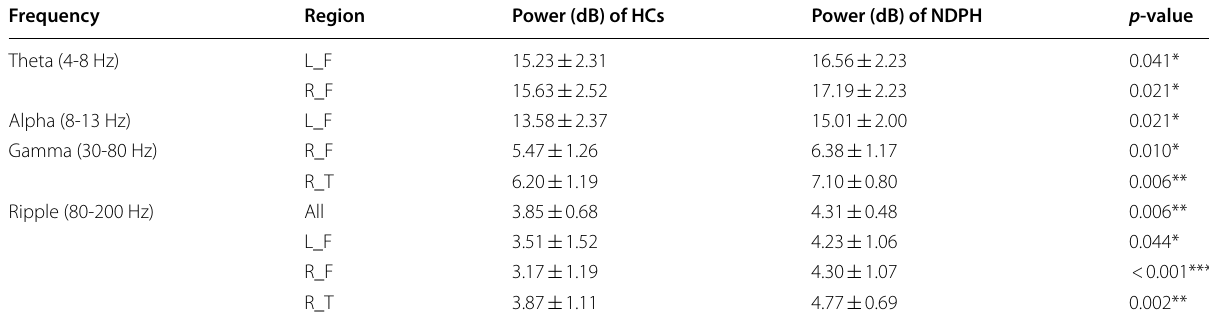
HCs Healthy controls; NDPH New daily persistent headache; All All brain regions; L_F Left frontal lobe; R_F Right frontal lobe; R_T Right temporal lobe